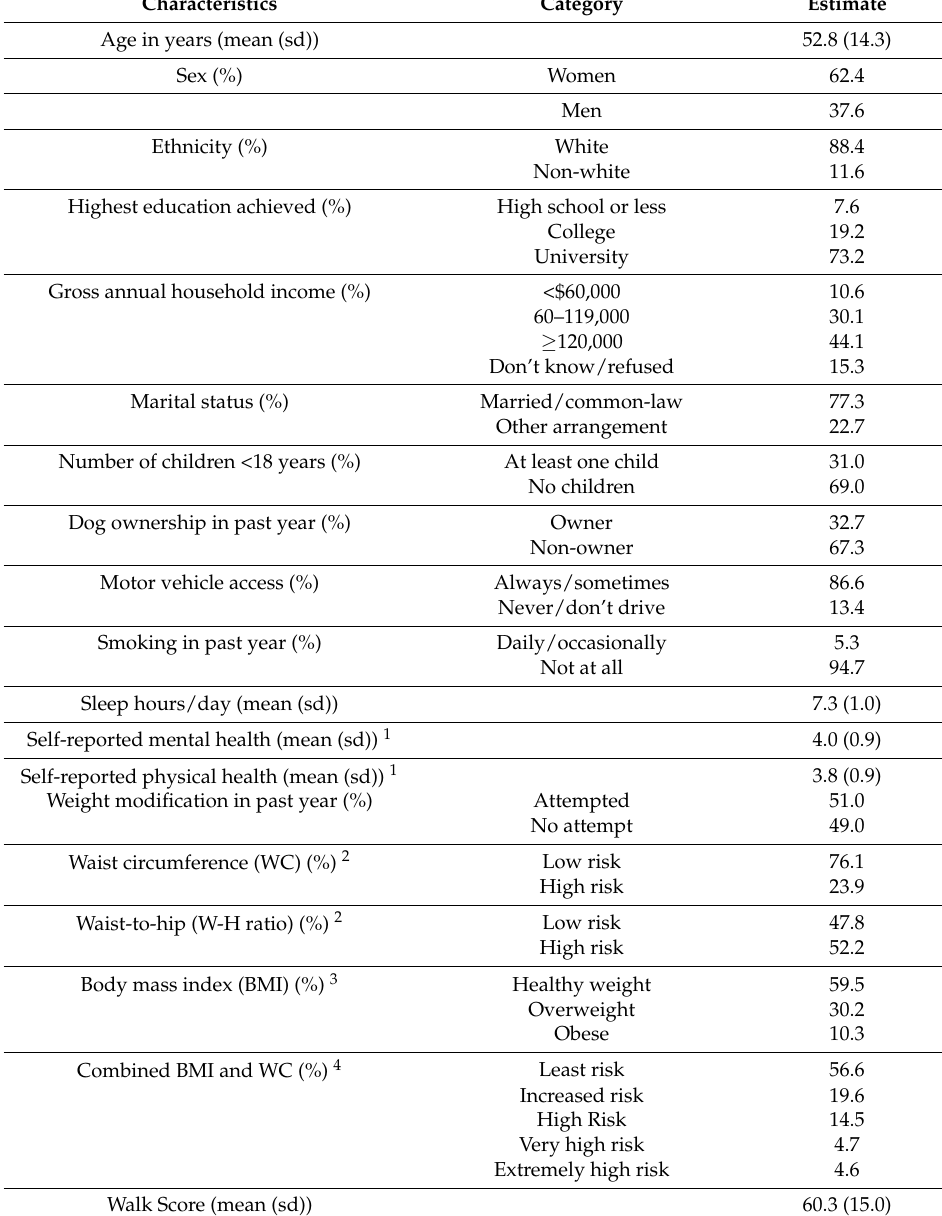
Table 1. Sample profile of sociodemographic, health, neighborhood, and weight status variables ( n =